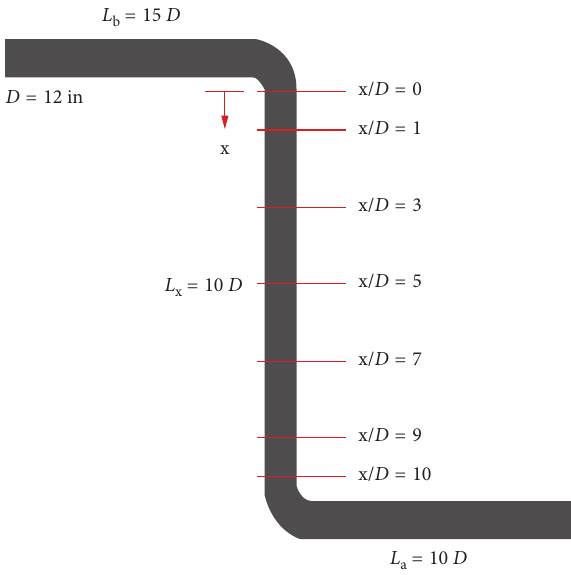
Figure 1: Computational domain.